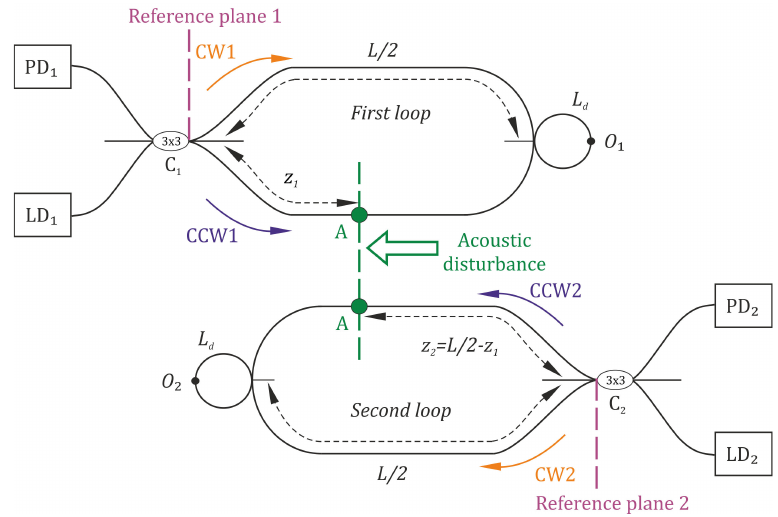
Figure 9. Two-loop diagram for sensitivity